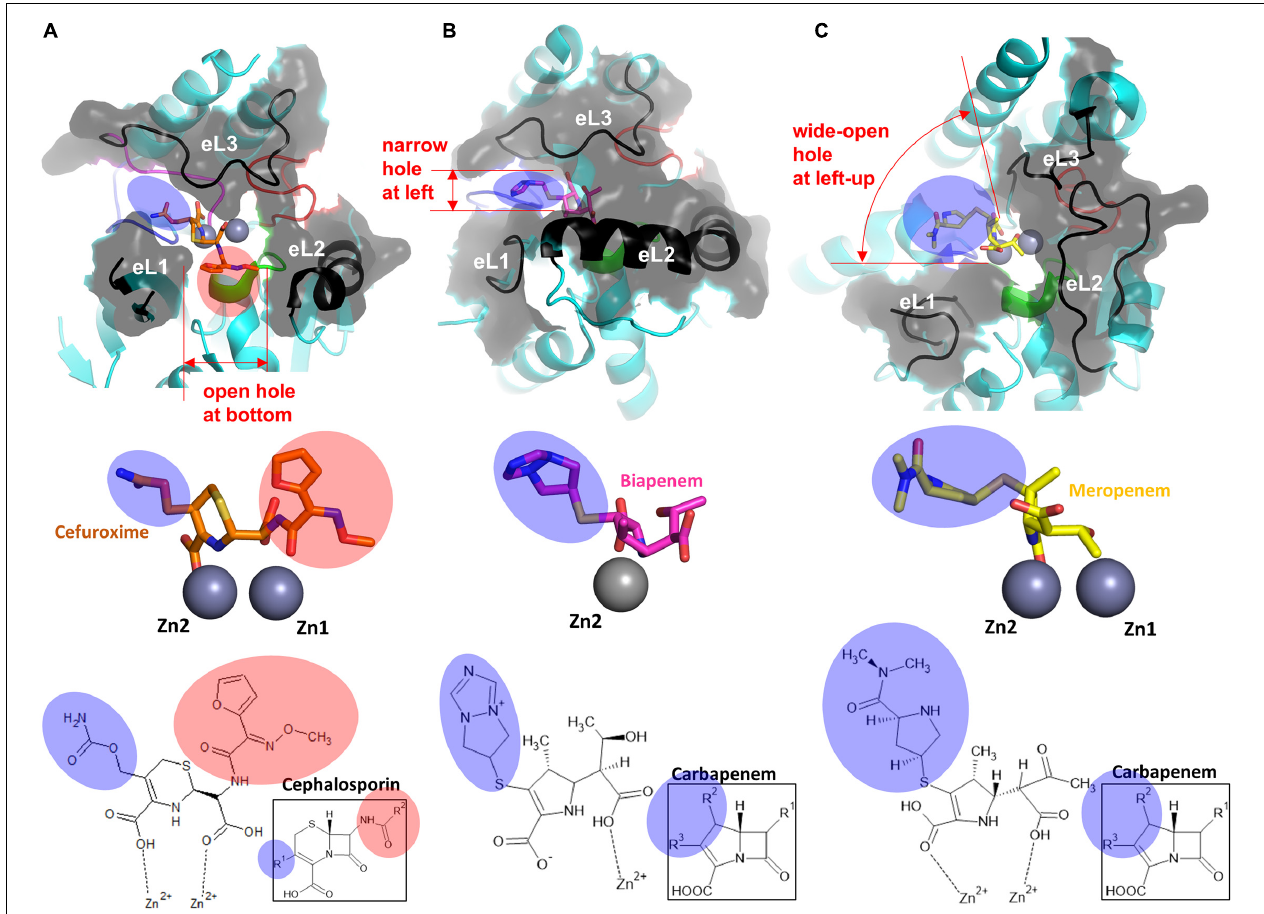
FIGURE 4 | The structure of the substrate-binding pocket forming eL1–3 of each subclass. The surface representation of eL1, eL2, and eL3 of (A) cefuroxime-bound NDM-1 (PDB ID: 3SPU), (B) biapenem-bound CphA (PDB ID: 1X8I), and (C) meropenem-bound SMB-1 (PDB ID: 5AXO) is shown at the top. The enlarged view of the hydrolyzed β -lactams with the zinc ion(s) is shown in the middle. The zinc ion(s)-bound chemical structures of β -lactams, including the core structures of each β -lactam group, are shown at the bottom. The substituted R groups at the four-member β -lactam ring are shaded in pink, and those at the five or six-membered dihydropyrrole ring or dihydrothiazine ring next to the β -lactam ring are shaded in